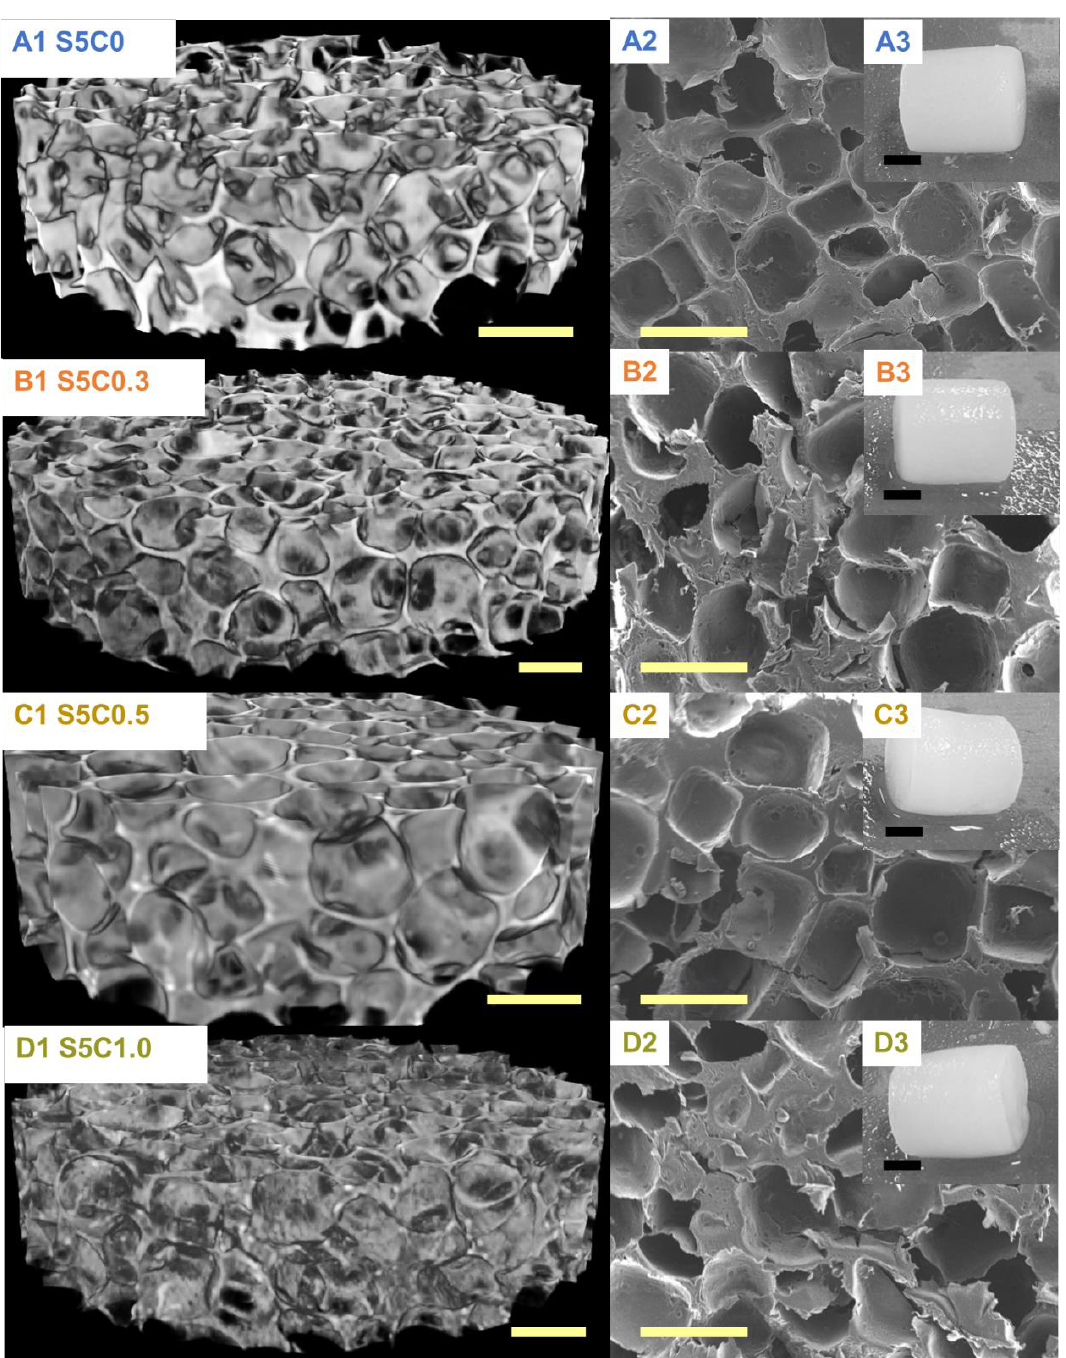
Figure 3. µCT images ( A1 – D1 ) and SEM photographs ( A2 – D2 ); yellow scale bar, 500 µm. Appearances of SF/cellulose hydrogels and control ( A3 – D3 ); black scale bar, 5 mm. A : S5C0, B : S5C0.3, C : S5C0.5, D : S5C1.0.